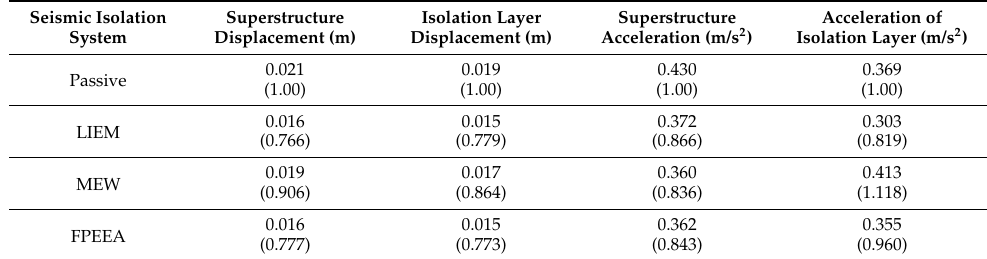
Table 7. Maximum responses of Whittier narrows-01 earthquake (PGA = 0.2g).